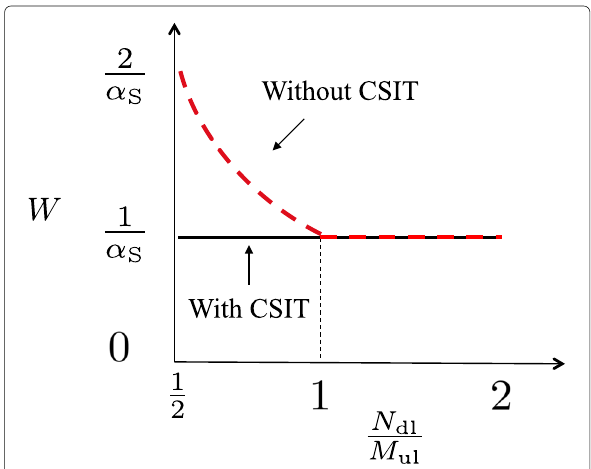
Fig. 8 Spatial spectral tradeoff in Case B when α I = 1